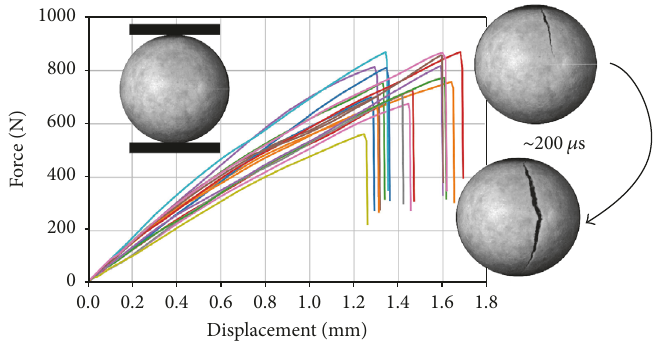
Figure 9: Quasi-static compression of hollow spheres (not all tests are presented).